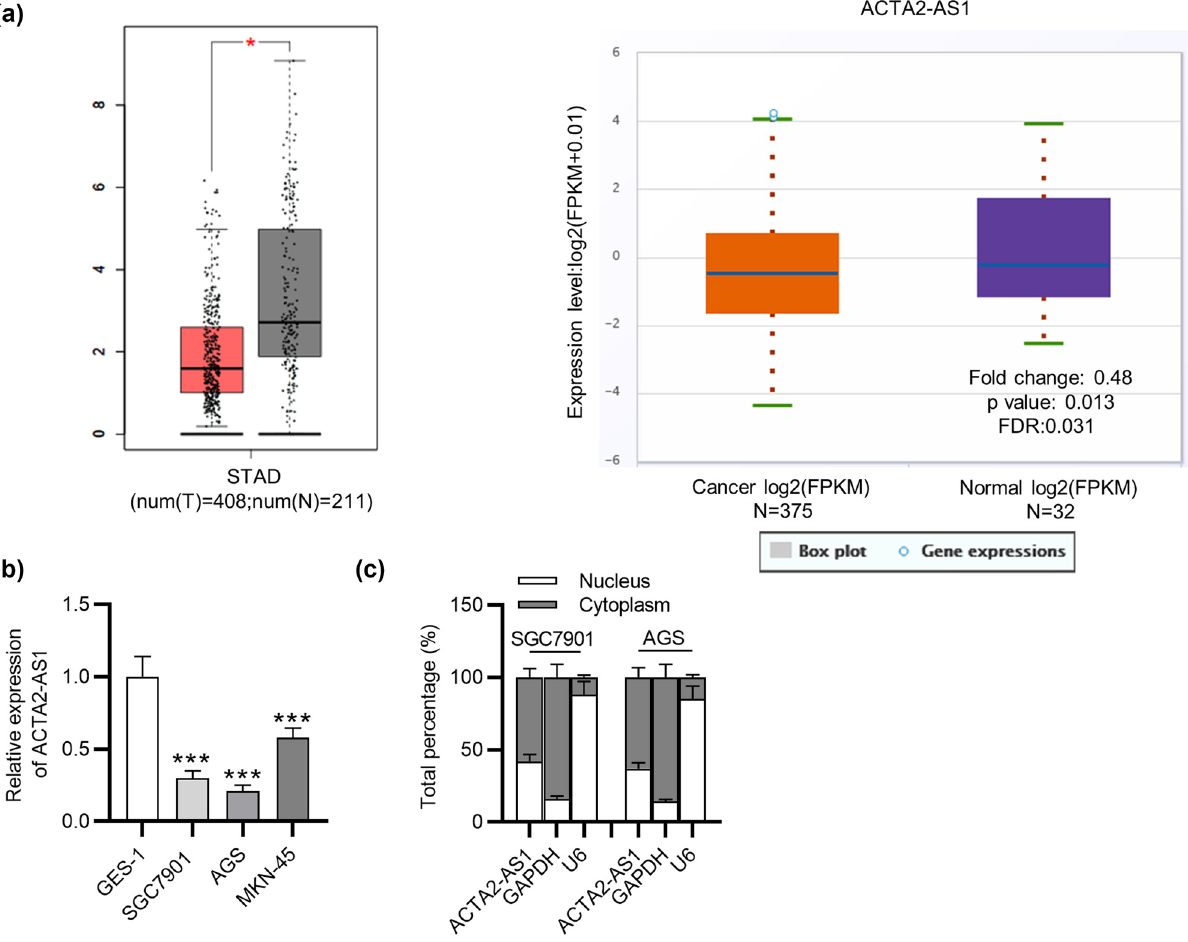
Figure 1: ACTA2 - AS1 is lowly expressed in GC cells and is mainly distributed in cytoplasm. ( a ) ACTA2 - AS1 expression in STAD tissues and normal tissues was analyzed by GEPIA and starBase websites. ( b ) ACTA2 - AS1 expression in human gastric epithelial cell lines and GC cell lines was examined by RT - qPCR. ( c ) Subcellular fractionation assays and RT - qPCR were performed to determine the distribution of ACTA2 - AS1 in GC cells. *** p <